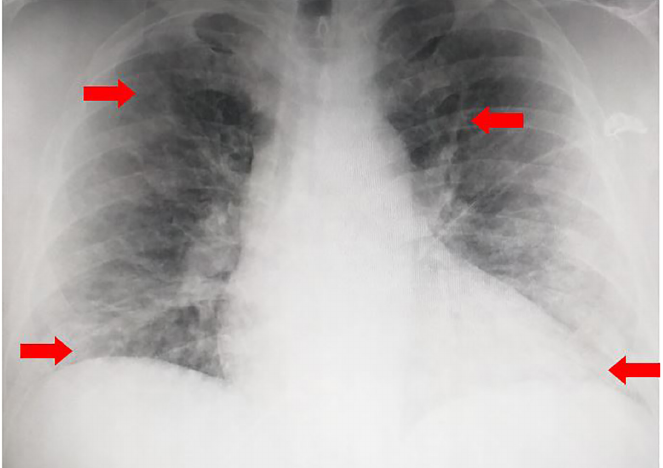
Image 3. Computed tomography angiography of the chest with intravenous contrast in the transverse view demonstrates moderate, scattered, diffuse pulmonary ground-glass and interstitial lung markings without pulmonary embolism as indicated by the red arrows. There is also mild subcutaneous stranding and edema of the anterior chest